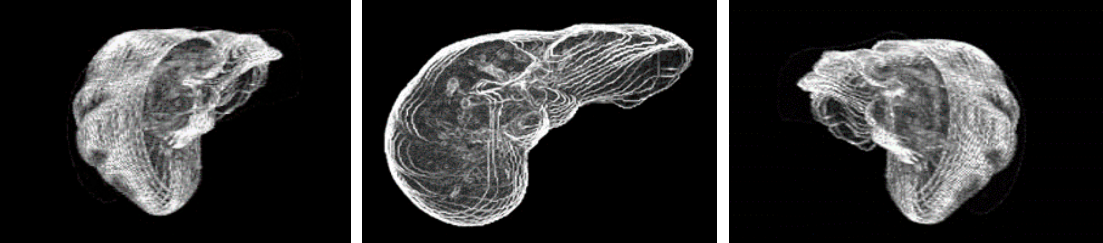
Figure 12. Reconstructive transparent 3D view of liver region [Rotate with the z -axis as the center].